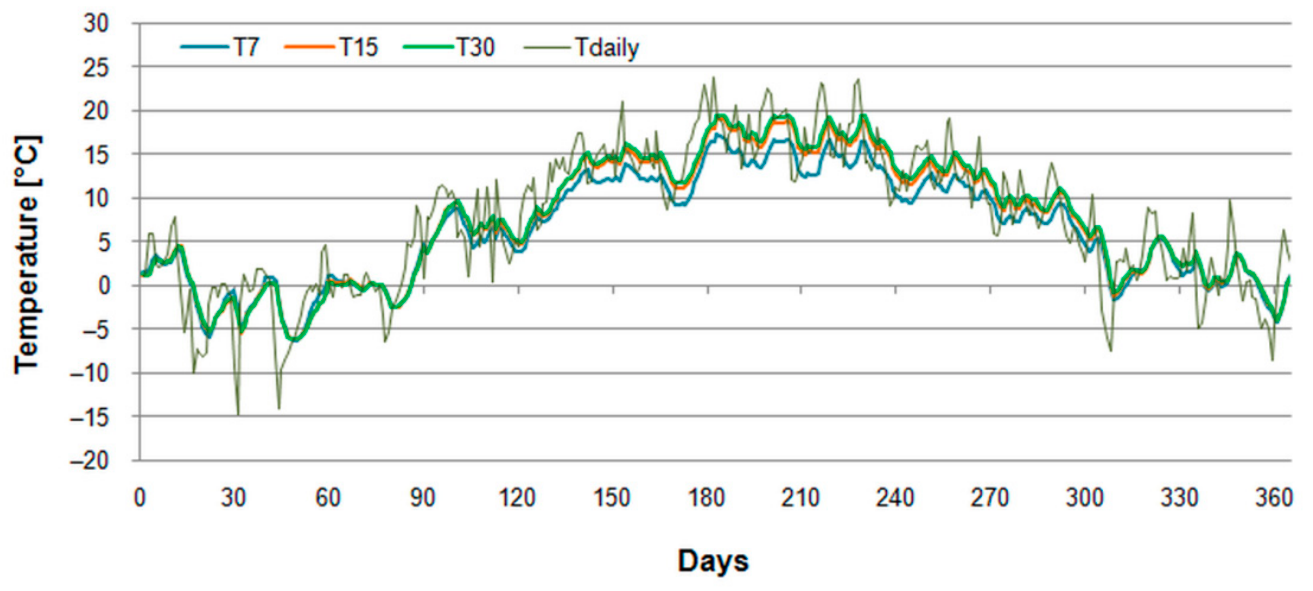
Figure 5. Daily mean outdoor temperature and running mean outdoor temperature as the weighted mean for different periods.